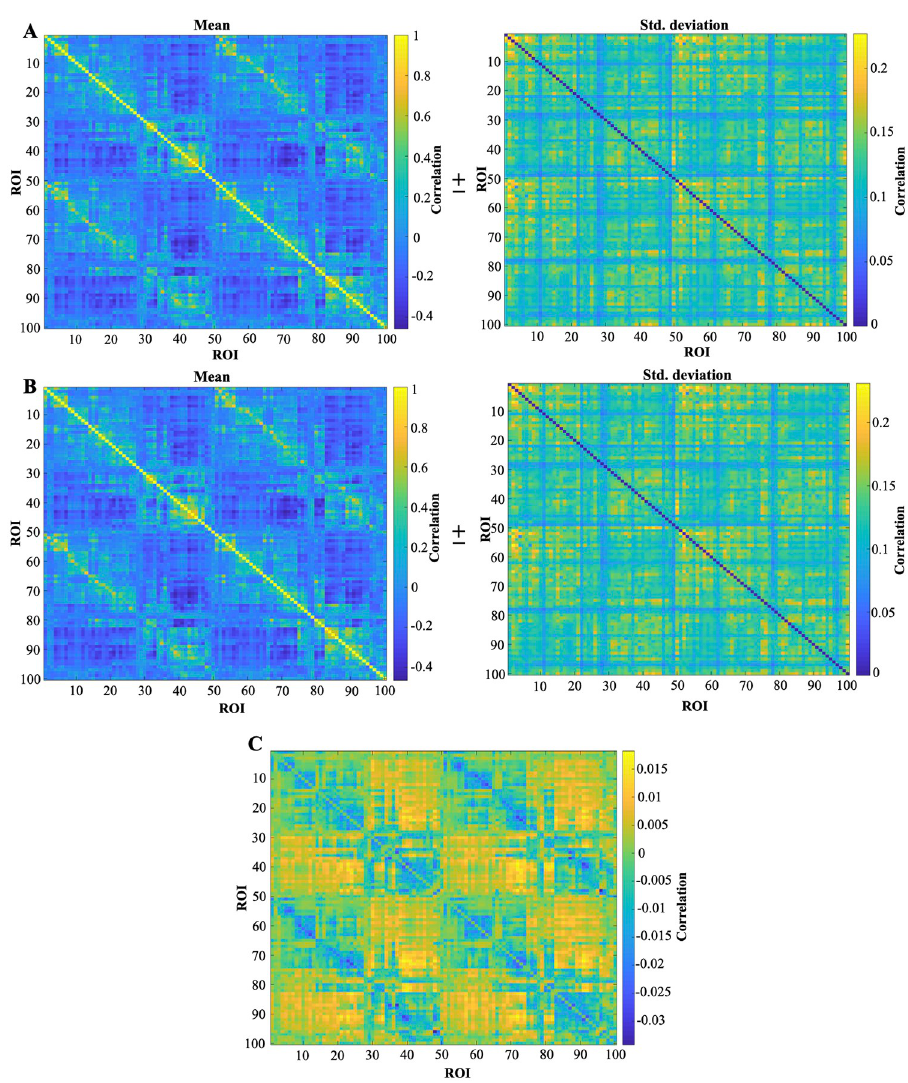
Fig 7. Whole brain FC matrix (comprising of 100 ROI) defined based on Pearson’s correlation. The Pearson’s correlation FC matrix of each subject in each run is averaged across to find one representative FC matrix (mean ± std. deviation). (A) Pearson’s correlation matrix (mean ± std. deviation) (for 100 ROI) obtained from the resting-state BOLD time series. (B) Pearson’s correlation matrix (mean ± std. deviation) (for 100 ROI) obtained from the ARFIMA (1, d , 0) filtered BOLD time series. (C) The difference between the mean Pearson’s correlation matrix of the resting- state BOLD dataset(A) and the filtered BOLD time series of the whole brain